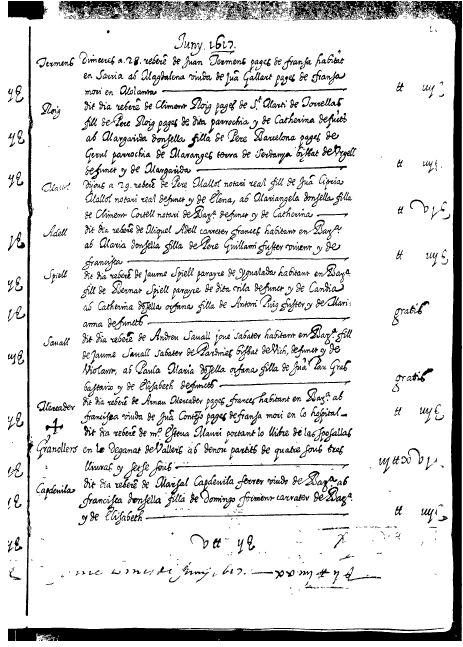
Figure 2. A document from the Barcelona historical, handwritten marriages database (BH2M)